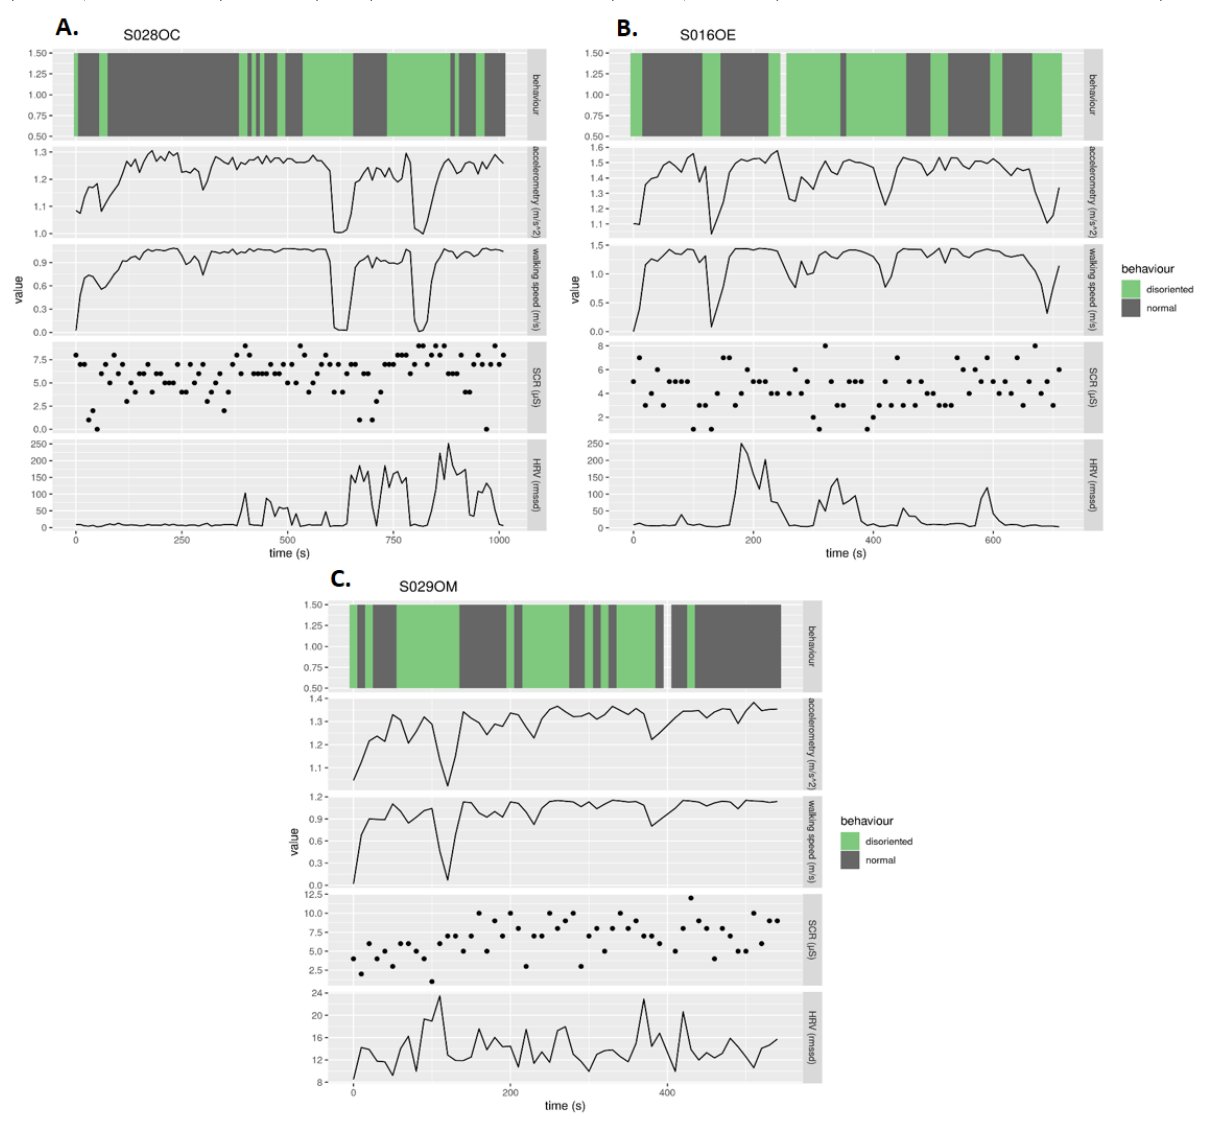
Figure 5. Sample of motion and physiological data showing variations in walking speed, accelerometry, heart rate, and skin conductance of participants occurring during instances of disorientation (green bars in the first row) from the unguided walk for (A) an older control participant (environment not manipulated), (B) an older experimental participant (environment was manipulated), and (C) a patient with dementia (environment not